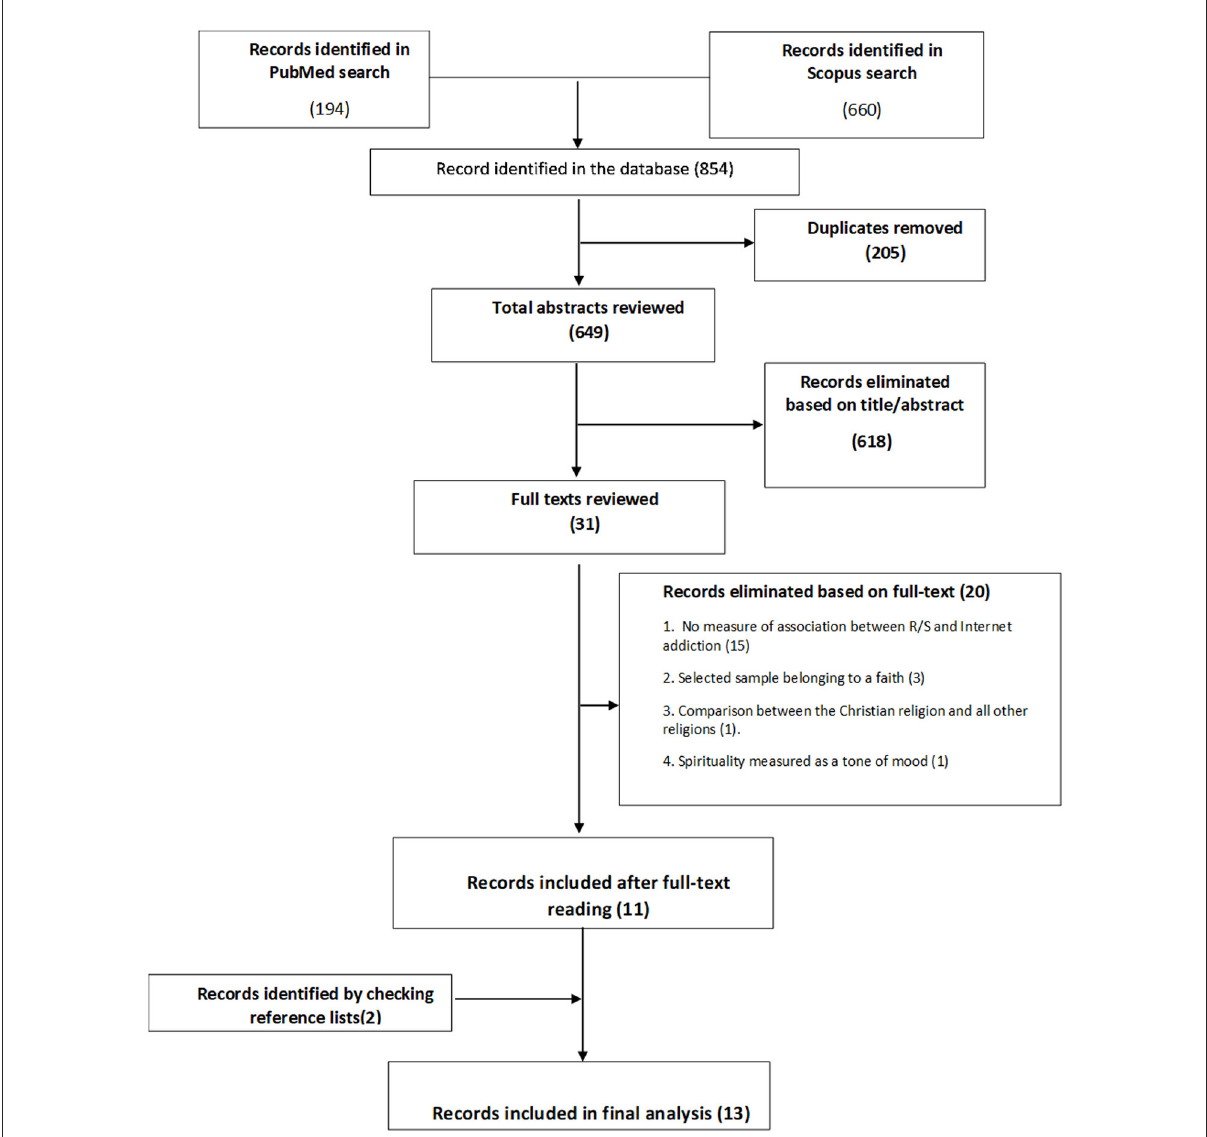
FIGURE1 Flow chart of the article selection process. R/S, Religiosity/spirituality; IA, Internet